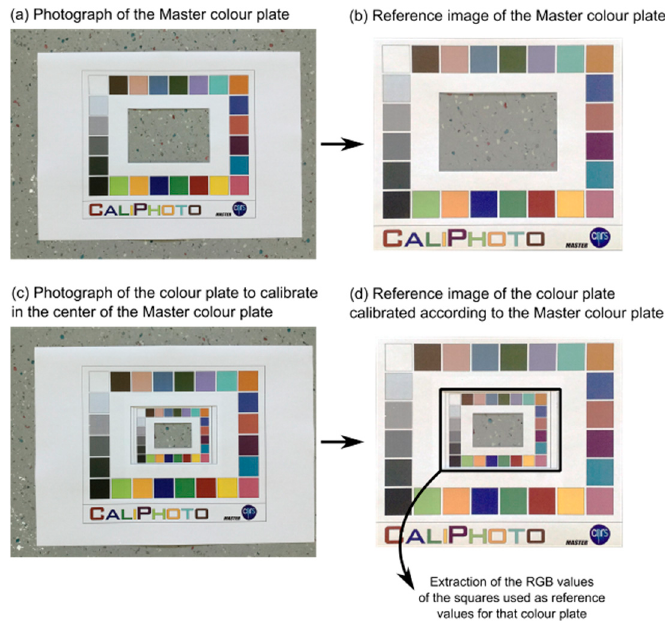
Figure A15. Calibration of a colour plate using a Master Colour plate. ( a ) Original photograph of the Master Colour plate. ( b ) Reference image after CaliPhoto reference colour plate image processing (Appendix B). ( c ) Photograph of the colour plate to be calibrated, which is placed in the centre of the Master Colour plate. ( d ) Reference image of the colour plate after CaliPhoto image processing.